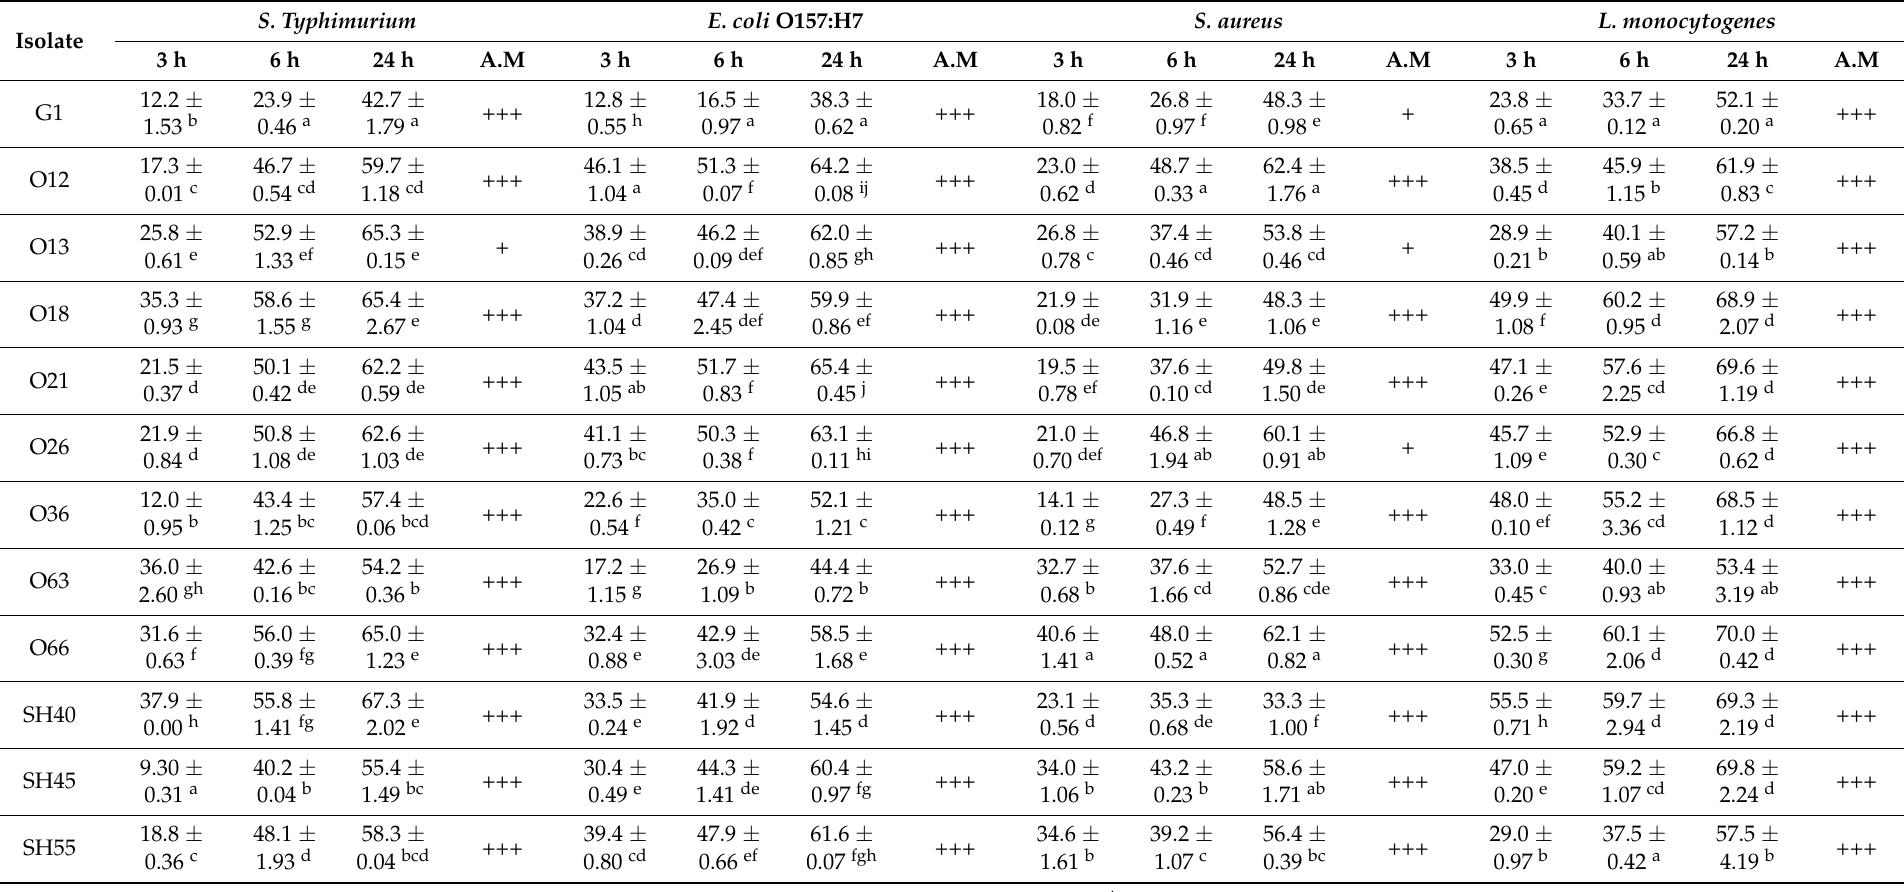
Table 4. Coaggregation (%) and antimicrobial activity of 12 potential probiotic yeast isolates against 4 foodborne